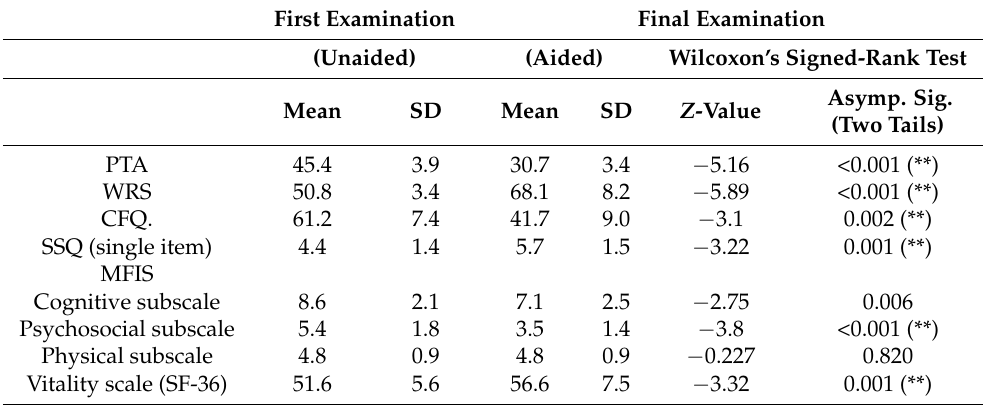
Table 3. Means and standard deviations (SD) of the hearing threshold (PTA), word recognition score (WRS), the Cognitive Failure Questionnaire (CFQ), the single item of the SSQ, and the Modified Fatigue Impact Scale (MFIS) subscales scores at the first and final assessment after patients’ acclimati- zation to hearing aids use are presented. The Wilcoxon signed rank test is expressed by Z -value and Asymptotic Significance (two tails). (**) = p < 0.005, (*) = p <